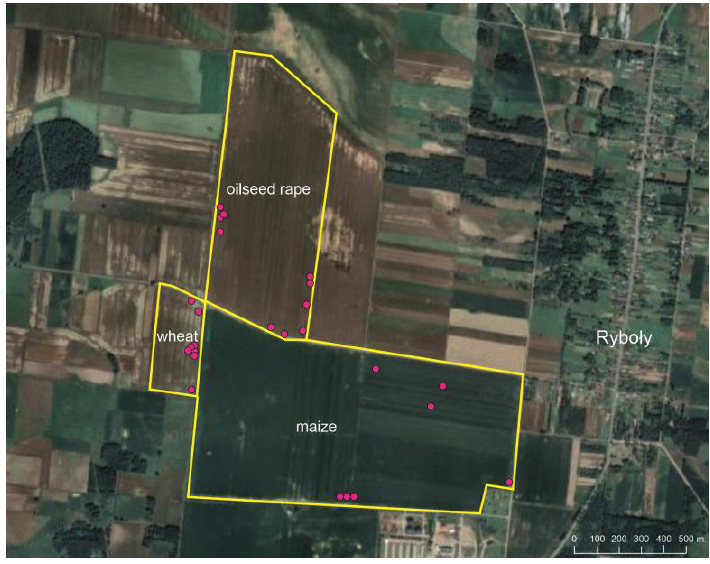
Figure 1. Location of eddy covariance tower (pink spots) on every test day on winter wheat, oilseed rape and maize fields.